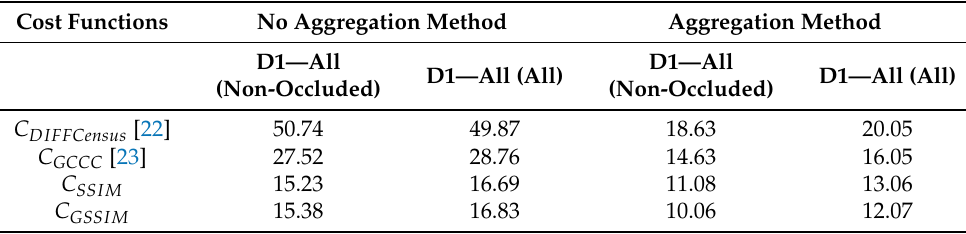
Table 2. Results on the KITTI 2015 training